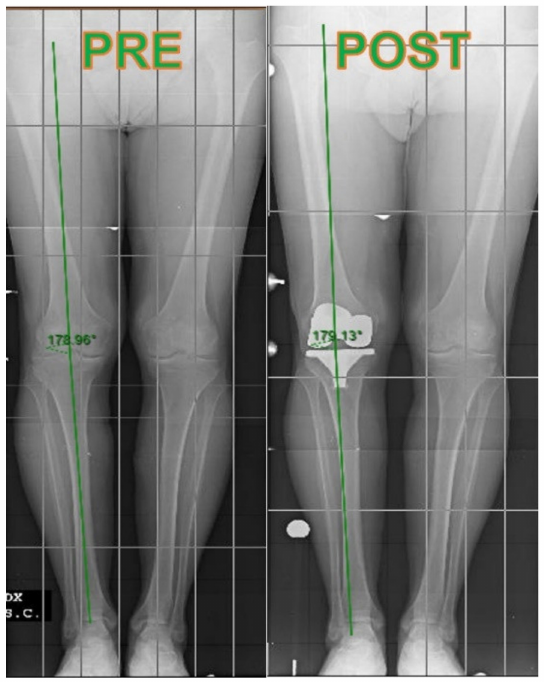
Figure 3. Pre and postoperative lower limb mechanical alignment. Table 4. Radiological